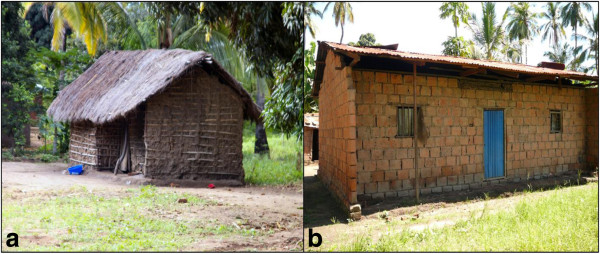
Representative house types commonly available in Idete and Namwawala villages. A temporary house (a) and a permanent house (b).